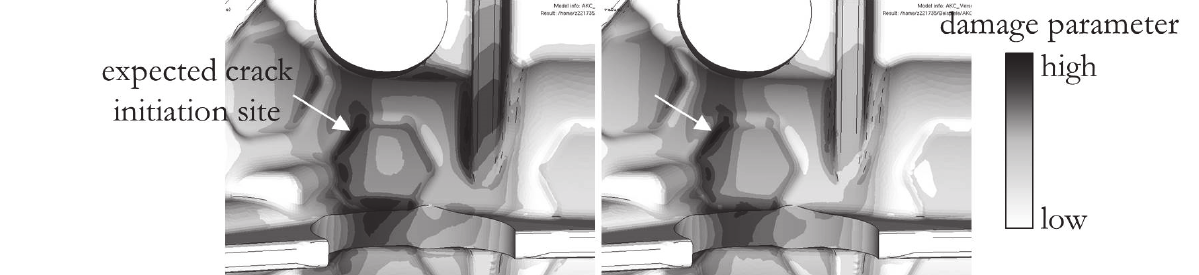
Figure 4: (cid:2026) (cid:3028),(cid:3049) for the result of the optimization (left) and the tradeoff